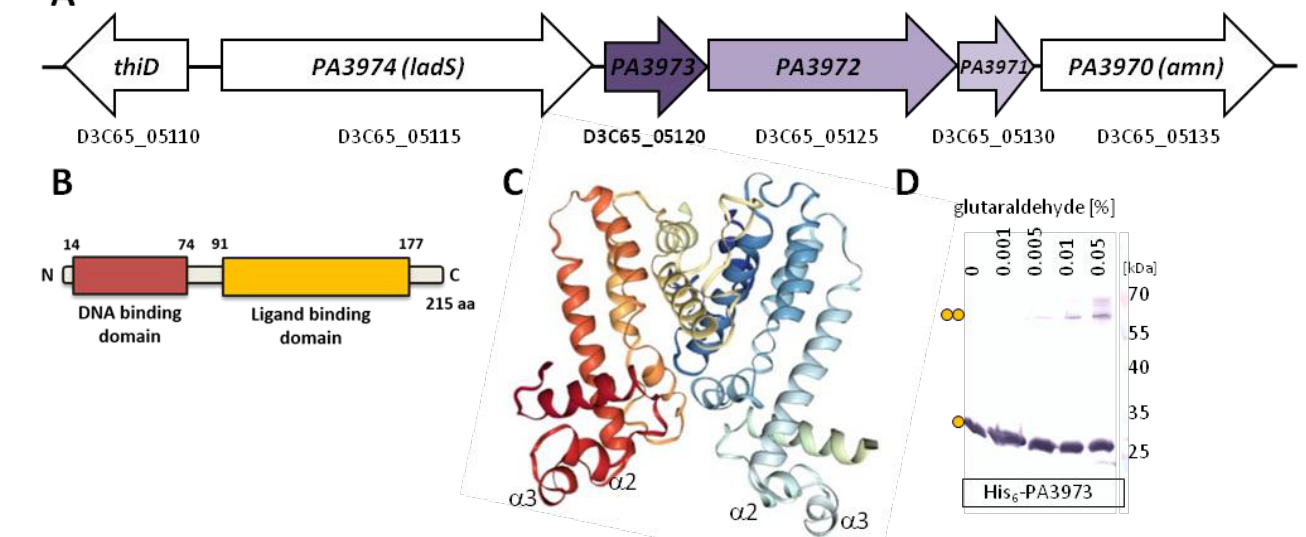
Figure 1. Properties of PA3973 protein from P. aeruginosa . ( A ) Genomic context of the PA3973 gene in the P. aeruginosa PAO1 genome. The gene names from PAO1161 and PAO1 strains are presented below and inside the arrows representing loci, respectively. The PA3973-PA3972-PA3971 gene cluster is shown in shades of purple. ( B ) Domain structure of PA3973 protein. ( C ) Structural model of PA3973 dimer obtained using AlphaFold2 and HDOCK [40,41]. Monomers are coloured in shades of red to khaki or navy blue to olive. The helices α2 and α3 constituting the HTH DNA binding domain are marked. ( D ) Analysis of the oligomerization state of purified His 6 -PA3973 by cross- linking with glutaraldehyde. Samples were separated by SDS-PAGE (12% gel) and analyzed by Western blot using anti-His 6 antibodies. Dimeric forms are marked by two dots. 2.2. Identification of PA3973-Regulated Genes and Binding Sites for this Transcriptional Regulator in the P. aeruginosa Genome To analyze the role of PA3973 in P. aeruginosa , a PAO1161 ∆ PA3973 mutant was con- structed. This mutant strain did not display obvious differences in growth in LB or M9 medium , swimming, swarming, twitching, or biofilm formation compared to the wild type (WT) parental strain PAO1161 (Figure 2A,B). In parallel, the effect of PA3973 overex- pression was tested by linking the gene to an IPTG (isopropy- β -D-thiogalactopyranoside)- inducible promoter in plasmid pKKB3.11 ( lacI q - tac p- PA3973 ). No effect of PA3973 over- production on bacterial growth was observed in P. aeruginosa under the tested gradient of IPTG in the growth medium (Figure 2C). To identify genes that display PA3973-dependent expression, we used RNA se- quencing analysis (RNA-seq). In addition, we performed chromatin immunoprecipitation and sequencing analysis (ChIP-seq) to identify PA3973 binding sites in the P. aeruginosa genome. The rationale behind an analysis of cells with PA3973 in excess was based on the following: (i) the relatively low level of PA3973 expression under standard growth condi- tions (LB or M9 medium; Bartosik AA, personal communication); (ii) the likelihood that an excess of PA3973 might mimic the induced, activated state of the protein; and (iii) the fact that the effector, signal, or partner for this TetR-type regulator is unknown.